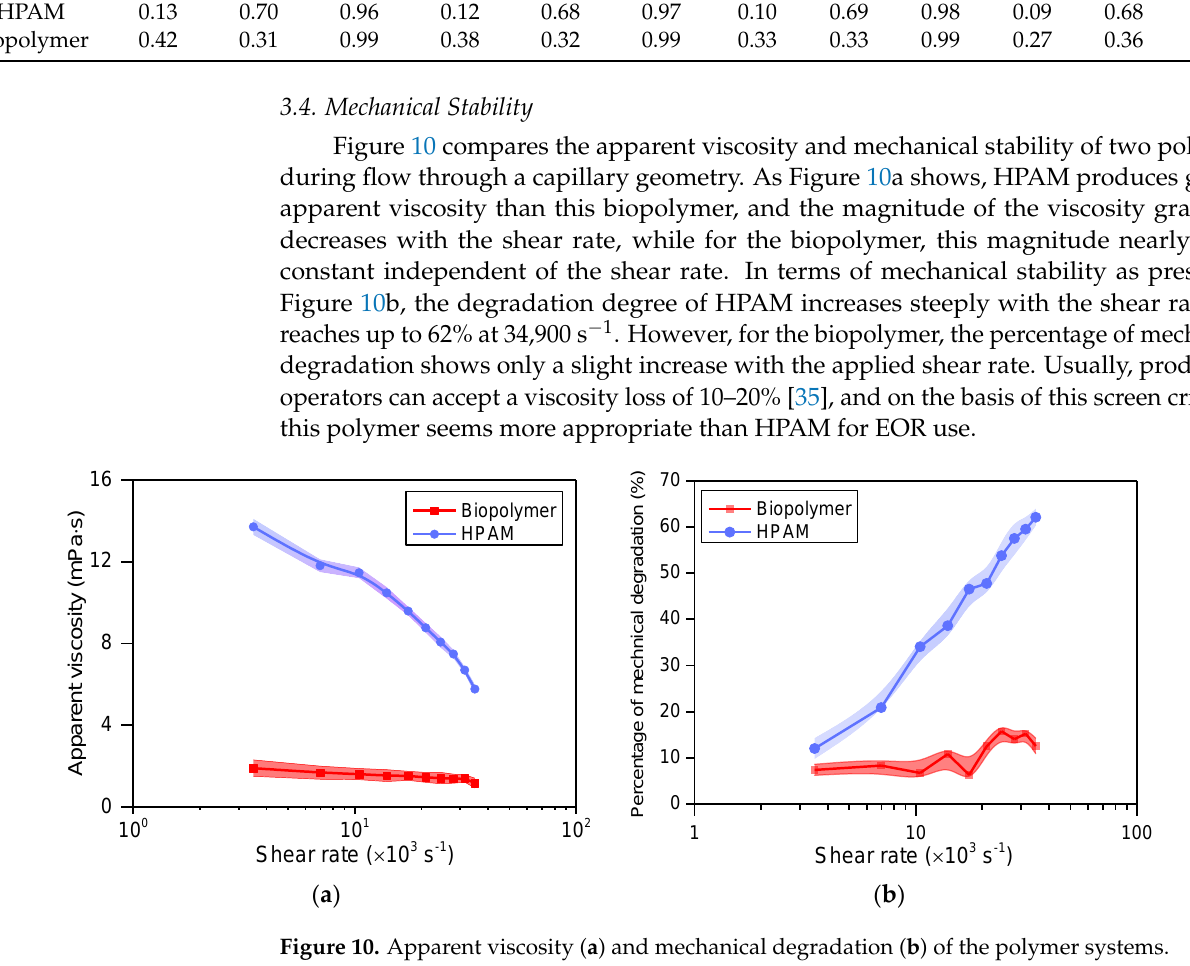
( b ) Figure 11. Shear viscosity of ( a ) HPAM and ( b ) the biopolymer after passing through the capillary (2 wt% NaCl).